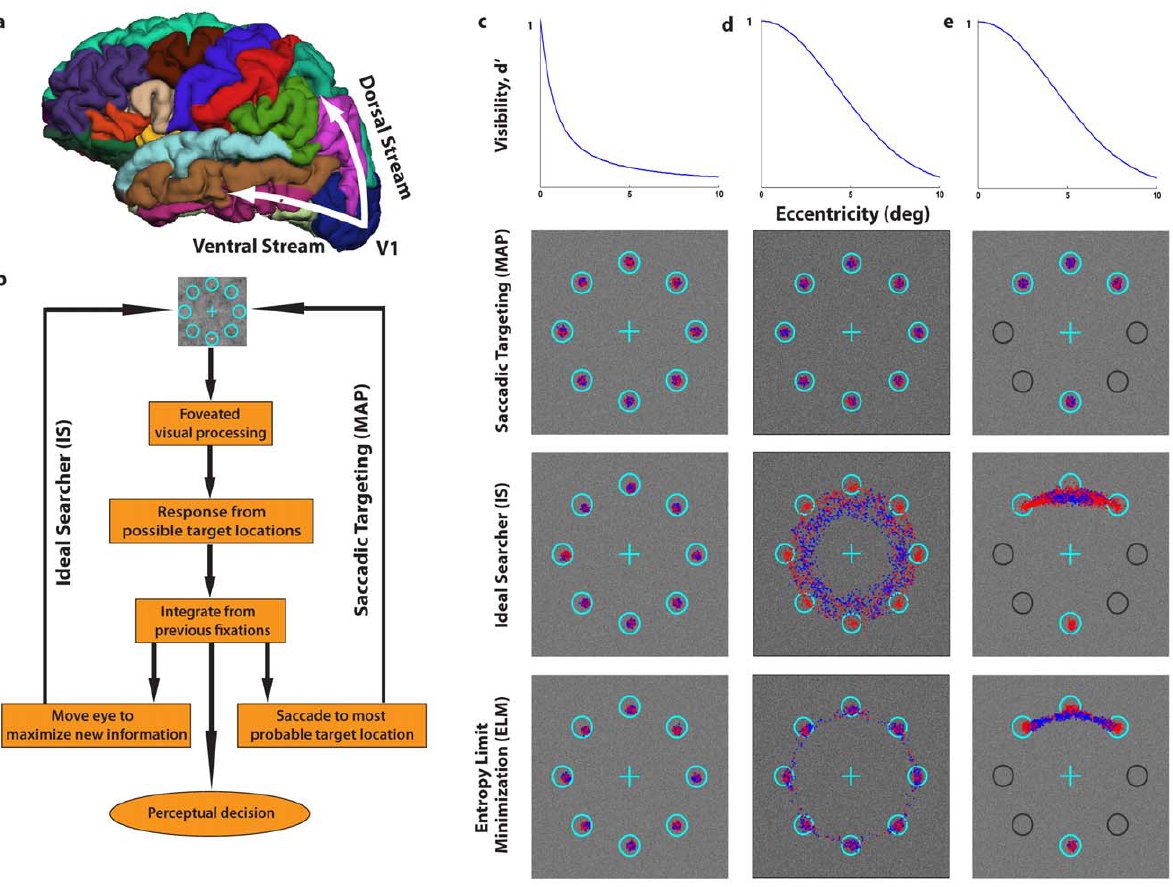
Figure 1.Virtual evolution of perception and saccade with different visibility maps, eye movement models and configurations. a. Ventral (perception) and dorsal (action) streams projecting from the primary visual cortex (V1). b. Flow chart for two models of human eye- movement search: Ideal Bayesian Searcher (IS) and the Saccadic targeting model (maximum a posteriori probability model, MAP). c. 8 alternative forced choice target search for steep visibility map. d. 8 alternative forced choice target search for broad visibility map. e. 4 alternative forced choice target search for broad visibility map. Light blue circles outline possible target locations. Location of fixations for 1 st (blue) and 2 nd saccades (red) for three models: IS, MAP and Entropy Limit Minimization (ELM) in white noise The MAP model simulations include small random saccade endpoint errors to facilitate visualization of the different fixations. Central cross indicates initial fixation point for all models. function of retinal eccentricity. The computational time demands of this simulation restricted us to evaluate this model for a fixed set of receptive field weights across eccentricities (see note 5 in Text S2) and limited set of scenarios: 1/f noise, steep visibility map and two targets: a low frequency Gaussian (Figure 5b; left) and a Difference of Gaussians (DoG) with a center frequency of 8 c/deg (Figure 5b; right). Due to the fixed set of weights across eccentricity, in this model the spatial profile of the linear combination of receptive fields scales up with eccentricity. Thus, for each retinal eccentricity category there was a pair of evolved template profiles. Figure 5c shows that convergent evolution still results when receptive field size increases with eccentricity and irrespective of the spatial frequency of the target. Figure 5d presents the similar radial profiles of the of evolved perception and saccade mechanisms for the fovea and a sample peripheral retinal location (perception and saccade 2-D template correlations for the best performing templates in the last generation averaged across retinal eccentricities were: Gaussian target: 0.963 6 0.008; DoG target: 0.961 6 0.004).